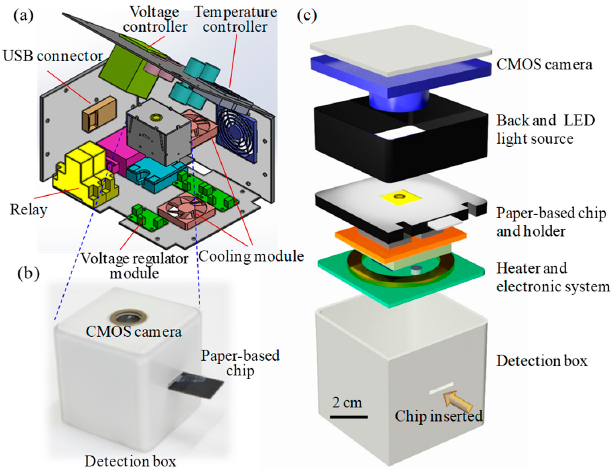
Figure 2. Photograph and schematic illustrations of: ( a ) main components of the smart detection device; ( b , c ) show detailed components of the detection box.